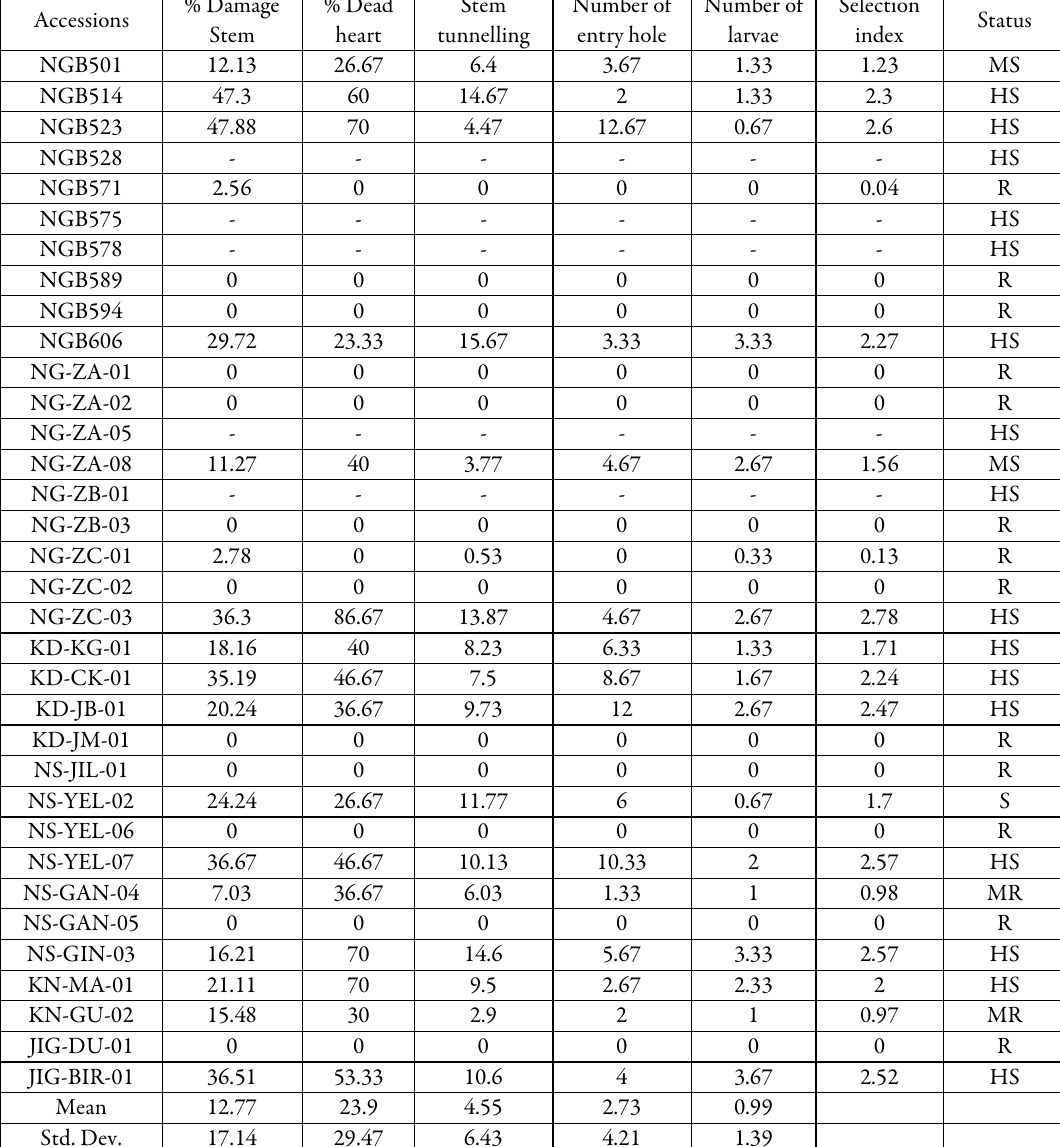
Table 3. Effects of Coniesta ignefusalis on 35 pearl millet accessions under field condition % Damage Accessions